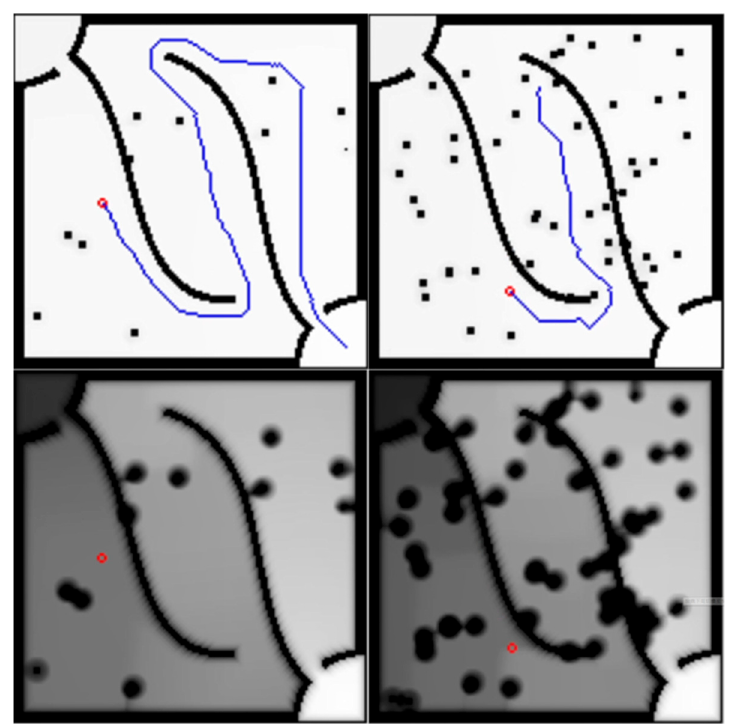
Figure 5. Real-time path planning with 10 and 50 obstacles.